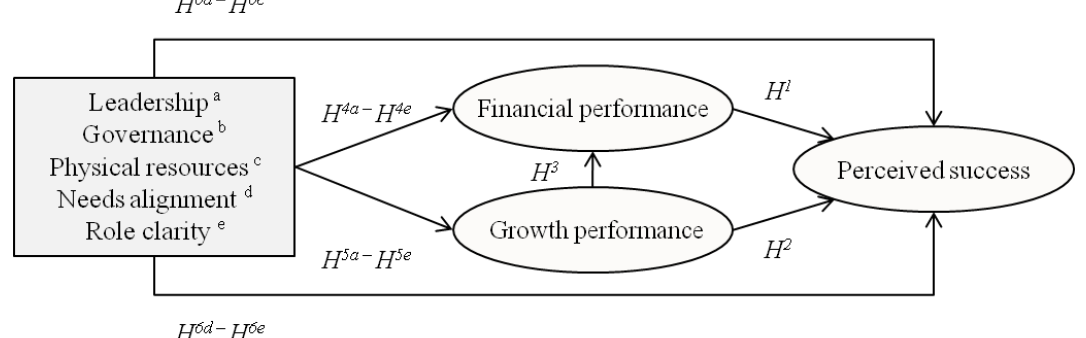
Figure 1: Hypothesised model of structural elements influencing successful